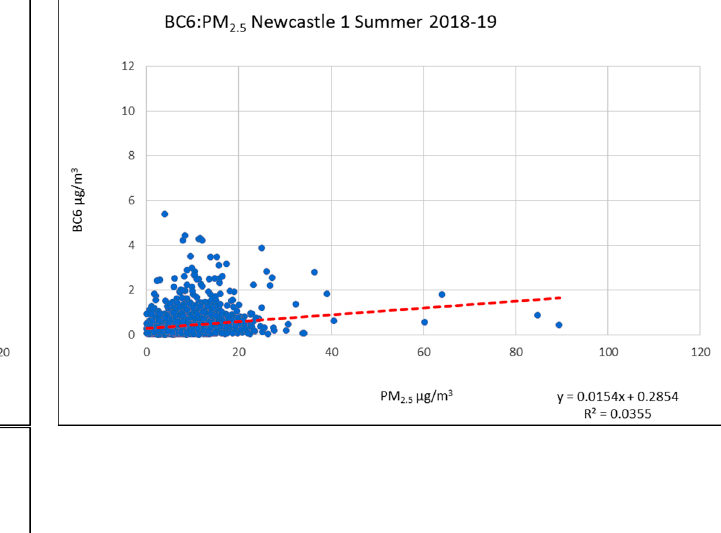
Figure 4. Regression of BC versus PM 2.5 for 2019 winter period at Liverpool, Richmond (Sydney region), Carrington, Newcastle (Lower Hunter region), Wollongong (Illawarra region), Wagga Wagga North and Armidale in regional New South Wales.